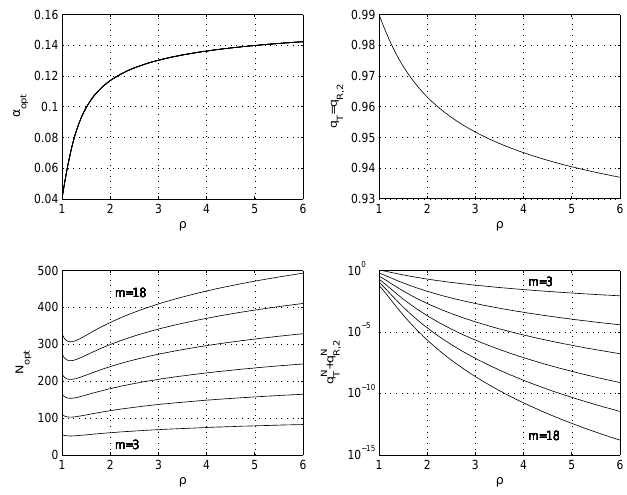
Figure 17. α opt versus ρ (top left graph), N opt versus ρ (bottom left graph), q T = q R, 1 versus ρ (top right graph) and q N and 18